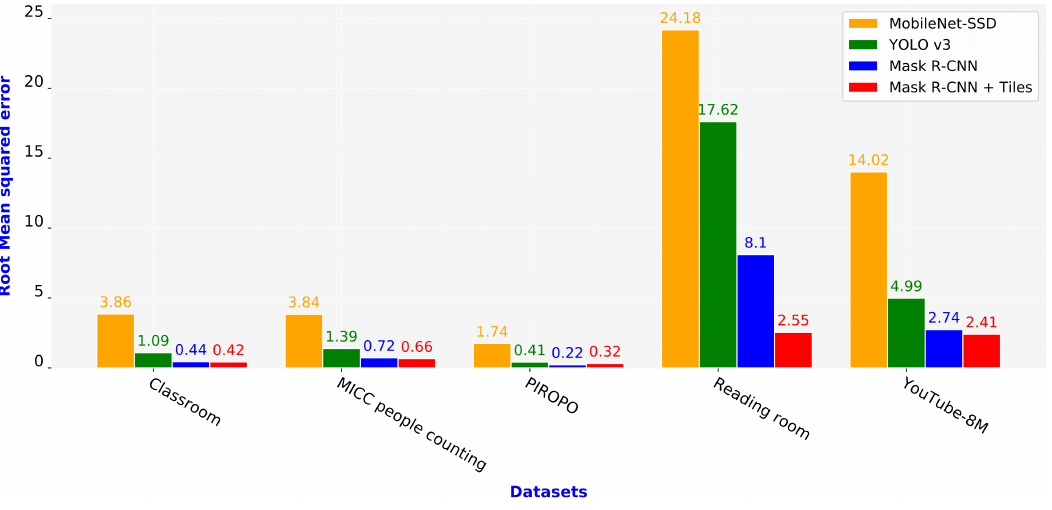
Figure 12. Root mean squared error of four schemes.